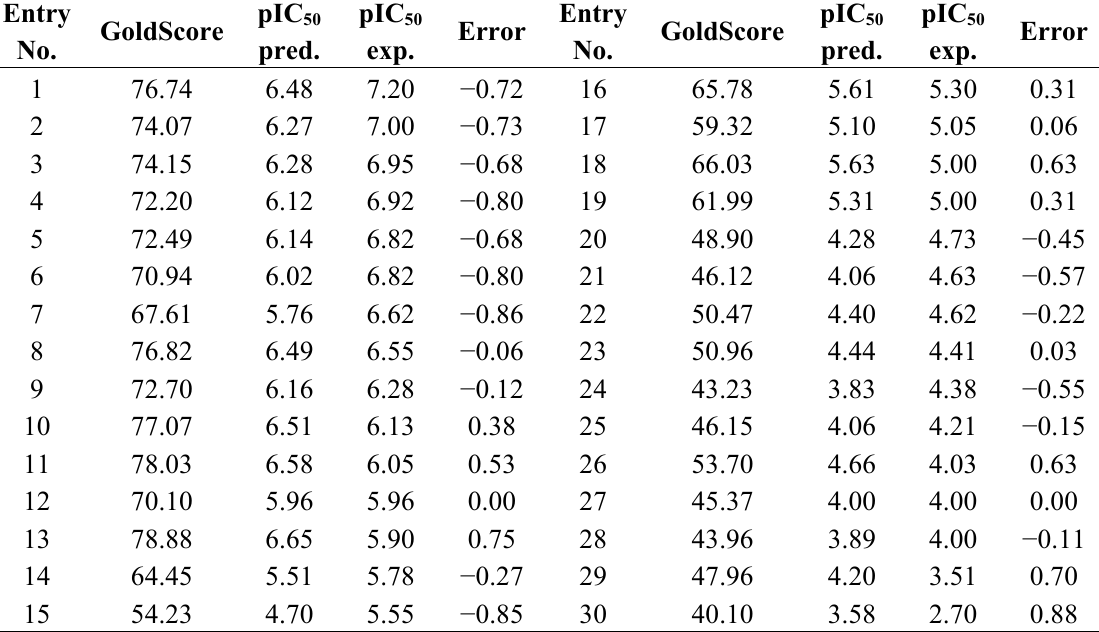
Table 2. Comparison of predicted and experimental activities for the test set. Compounds experimental are sorted by decreasing pIC 50